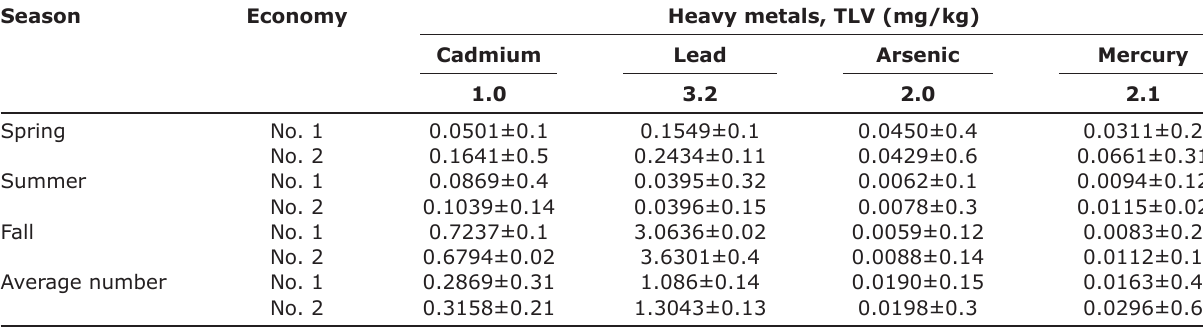
Table-1: Average content of heavy metals in soil samples by season, mg/kg (M±m).